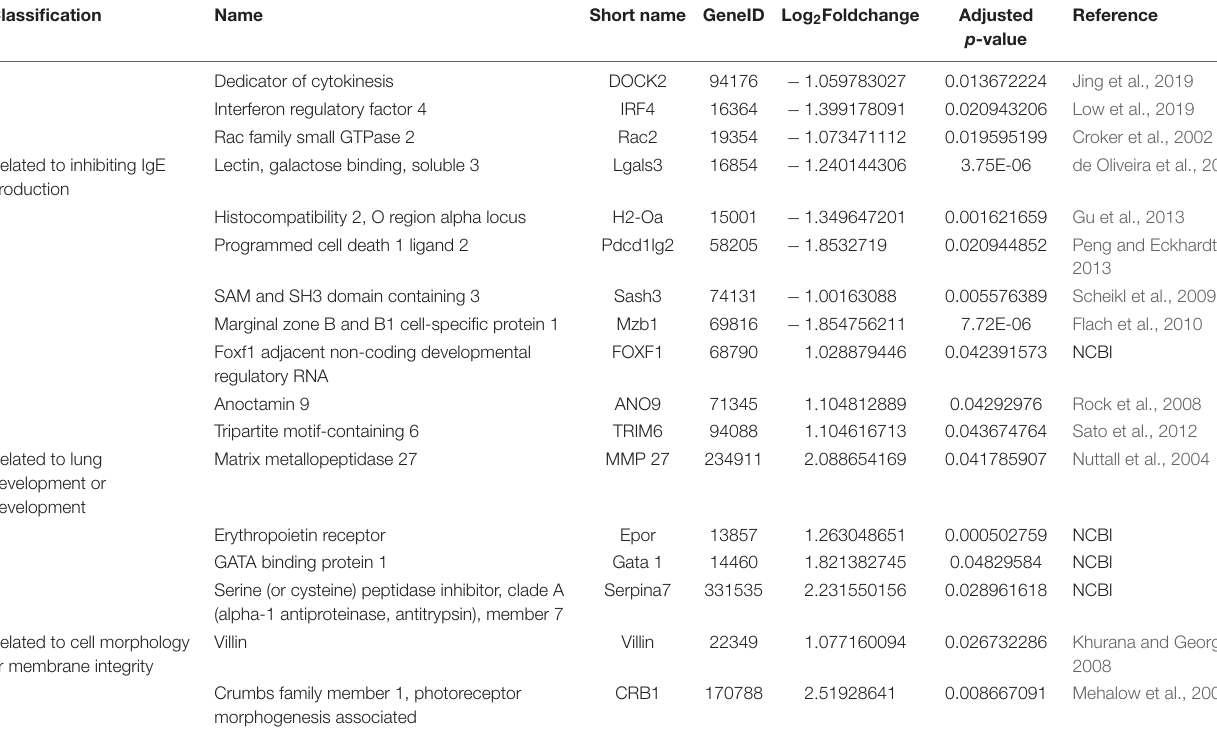
TABLE 2 | Differential expression genes reported to facilitate B cell or plasma cell, lung development, and cellular morphology.